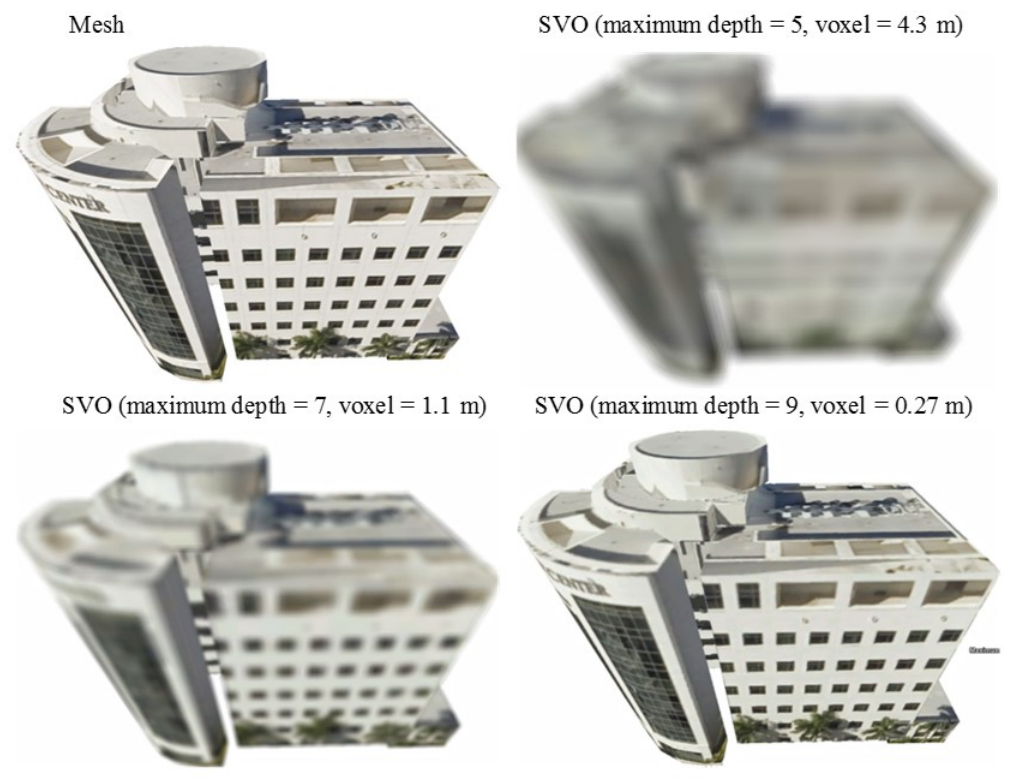
Figure 7. Comparison of the triangular mesh representation and SVO representation at various depths.